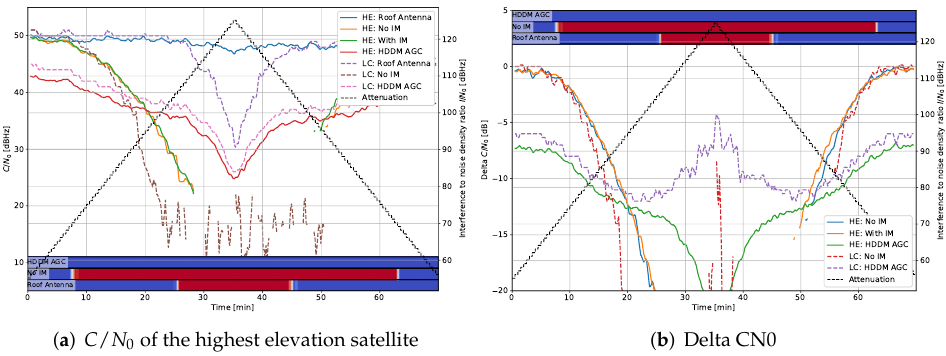
Figure A17. Interference #8: Filtered pulsed noise with 35MHz bandwidth, 50% duty cycle, and 1ms pulse width with Galileo E1BC.